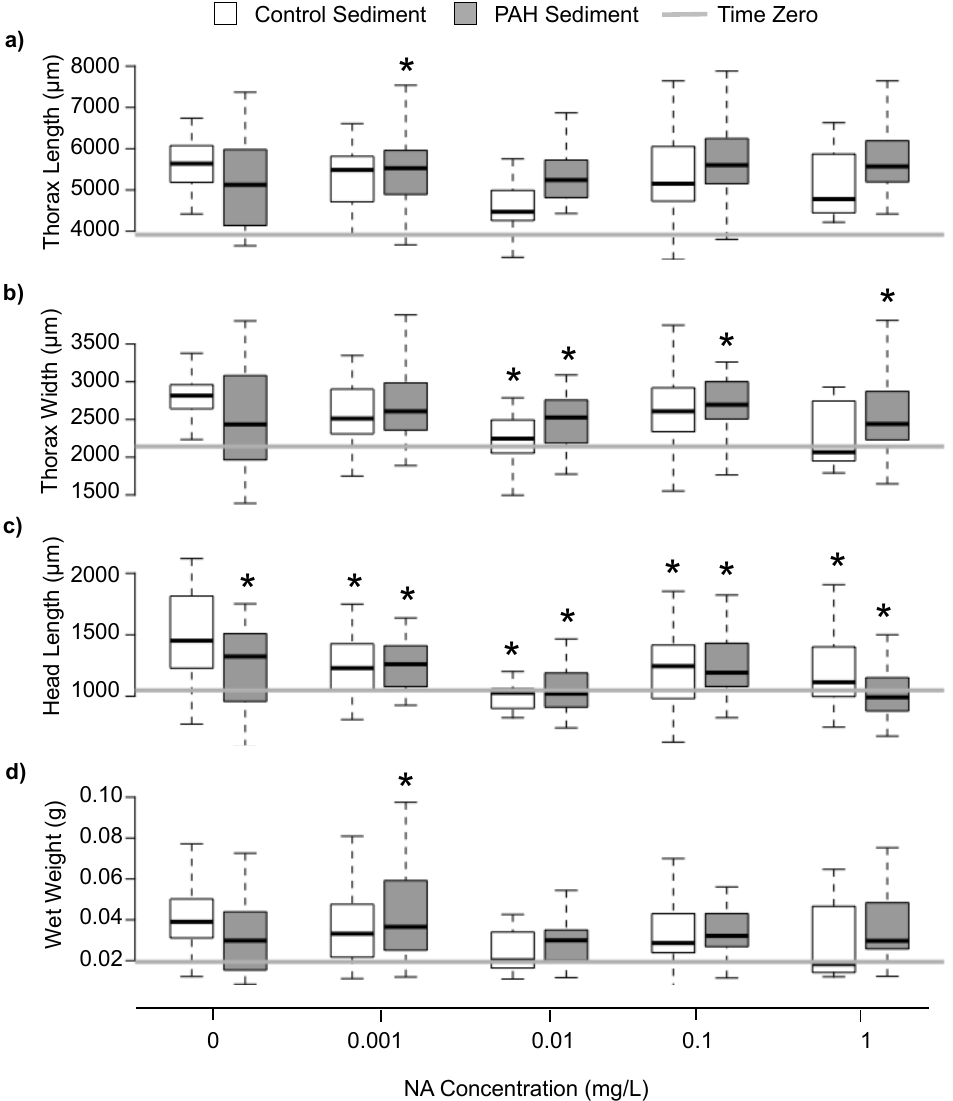
Figure 4. Boxplot comparison of sublethal changes (showing the maximum, 75 th percentile, median, 25 th percentile and minimum) in thorax length ( a ), thorax width ( b ), head length ( c ), and wet weight ( d ) in Hexagenia mayfly nymphs exposed to an NA mixture in either control (white, left) or PAH-spiked sediment treatments for a 21-day period. Significant differences from the control (0 mg/L NA and control sediment, far left bar) are indicated by “*” and time zero measurements are indicated by grey horizontal lines for comparison.